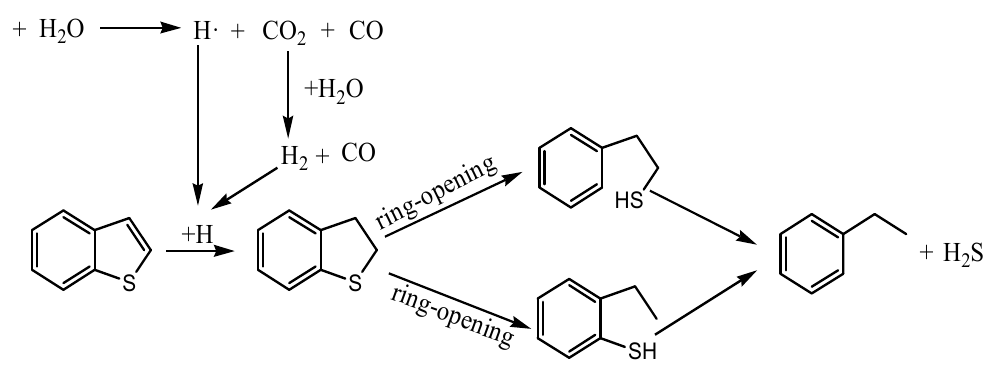
Figure 17. Aquathermolysis reaction mechanism of benzothiophene.